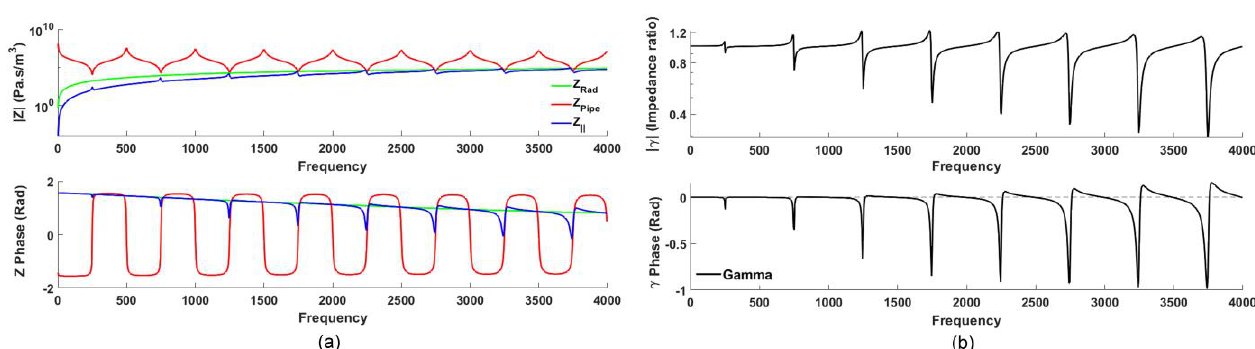
Figure 1. ( a ) Impedance (analytical model) for a theoretical baffled open-closed cylinder with a length of 340 mm and a radius of 13 mm: magnitude (upper), and phase (lower) spectra plotted for open-close Z Pipe (red), Z Rad (green) and Z || (blue); ( b ) γ (ratio of Z || to Z Rad ) spectrum (black), magnitude (upper) and phase (lower). The “notches” (magnitude) and “dips” (phase) indicate resonances in Z Pipe [9].